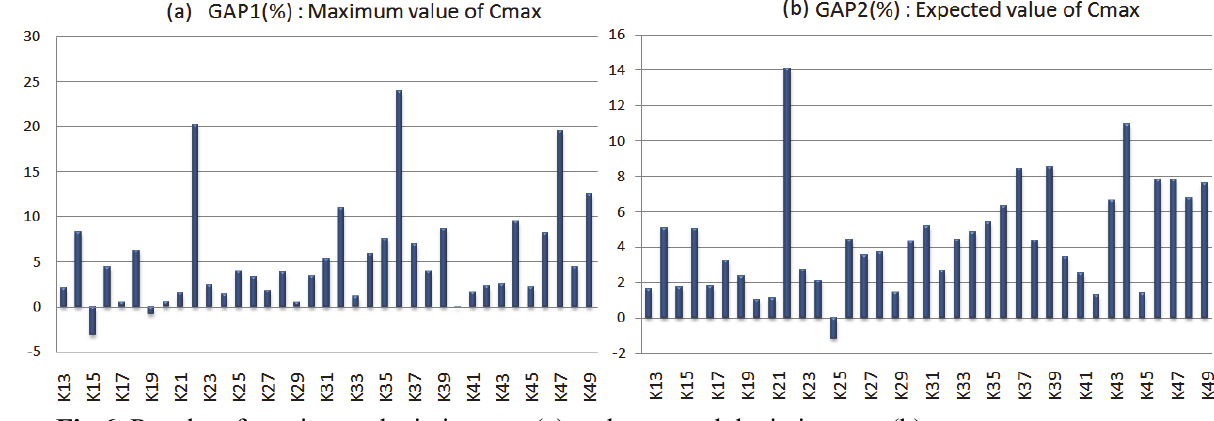
Fig 6. Results of maximum deviation rate (a) and expected deviation rate